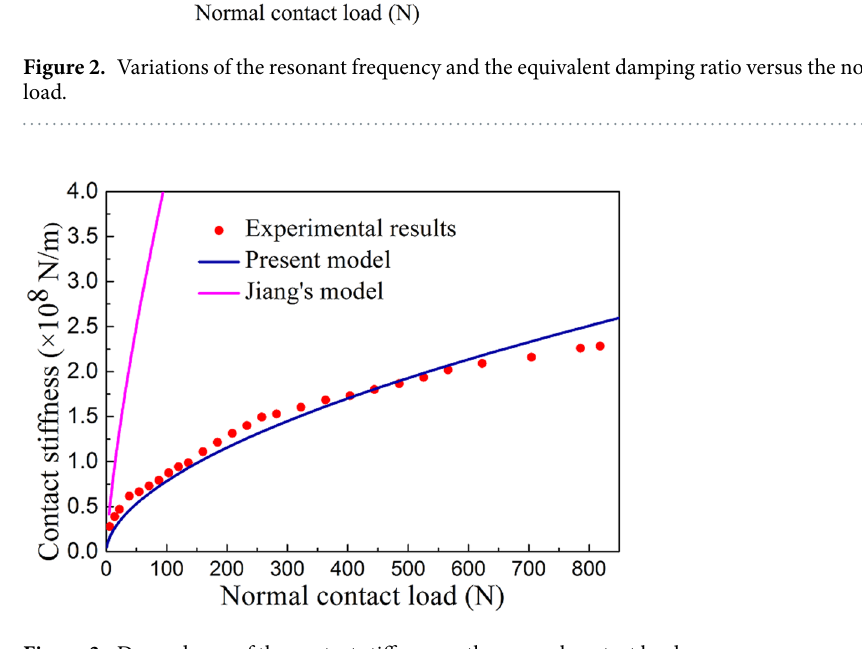
Figure 3. Dependency of the contact stiffness on the normal contact